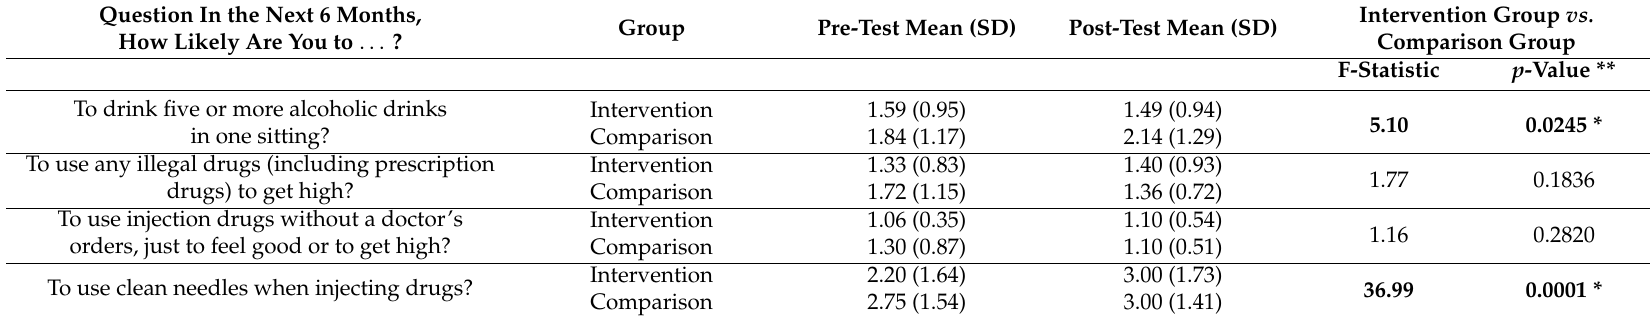
Table 2. Results of ANOVA (Generalized Linear Model) Difference of Intervention versus Comparison Group in Substance Abuse Behavioral Intentions. Question In the Next 6